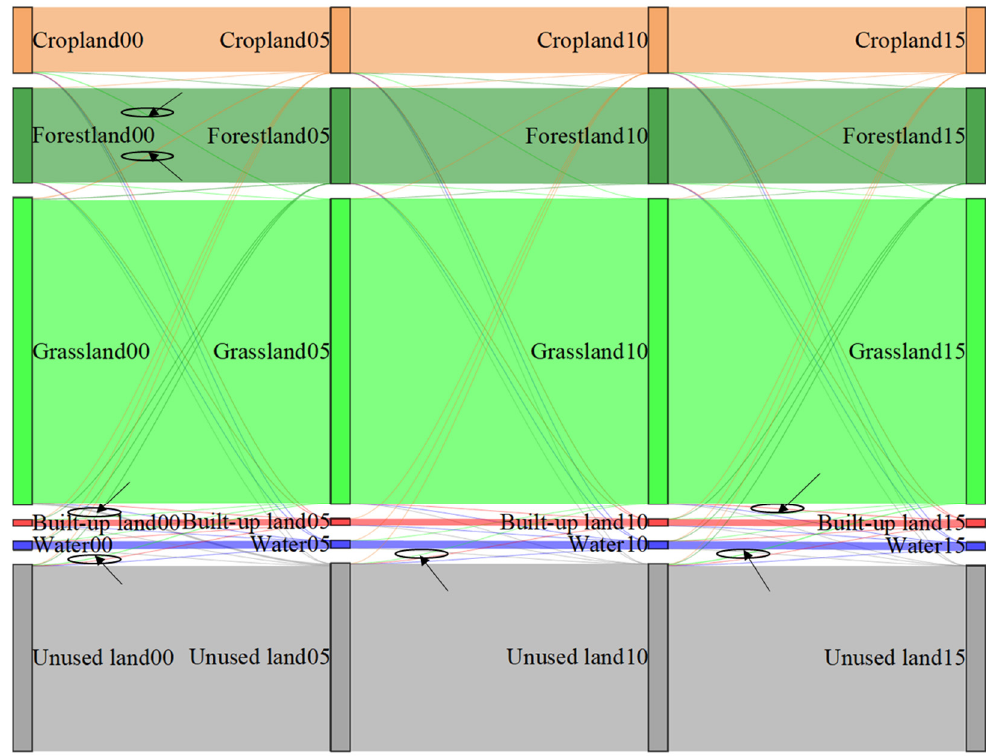
Figure 4. Sankey diagram of the landscape transfer matrix (km 2 ).